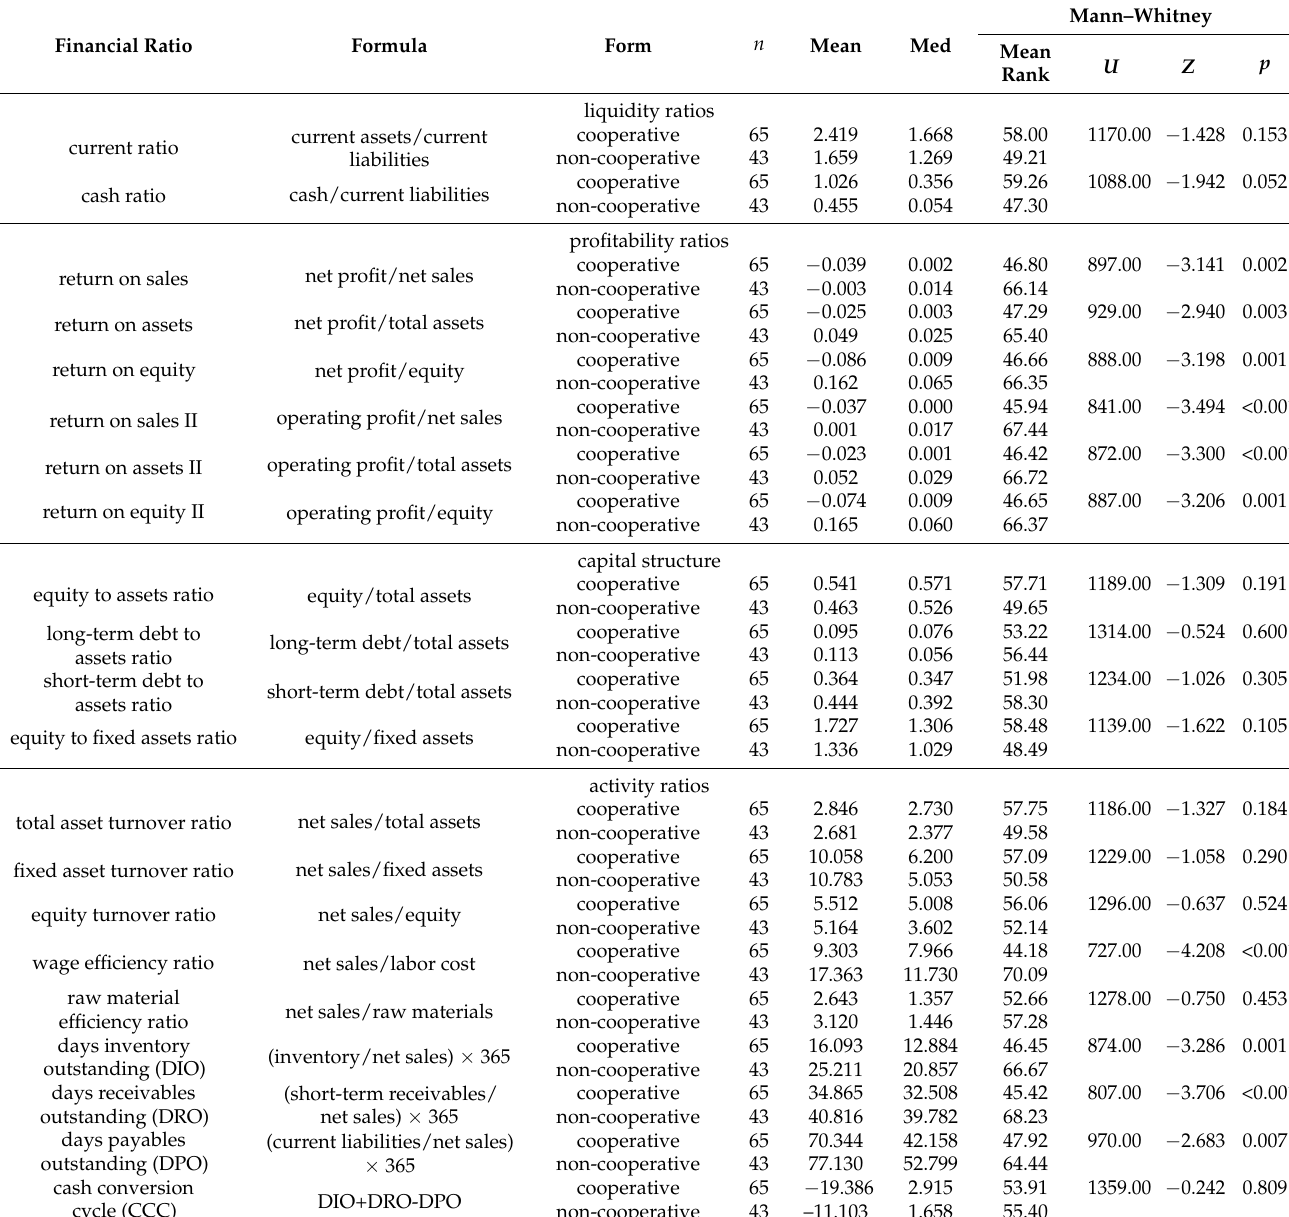
Table 1. A comparative analysis of financial ratios for cooperative and non-cooperative dairies for the year 2019 (authors’ calculations based on